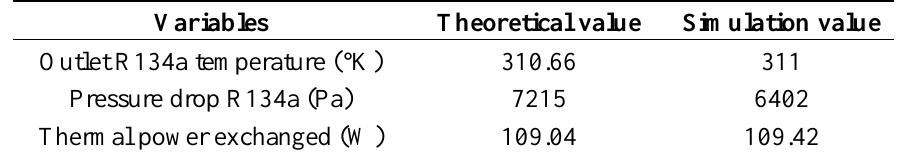
Table 11. Simulation